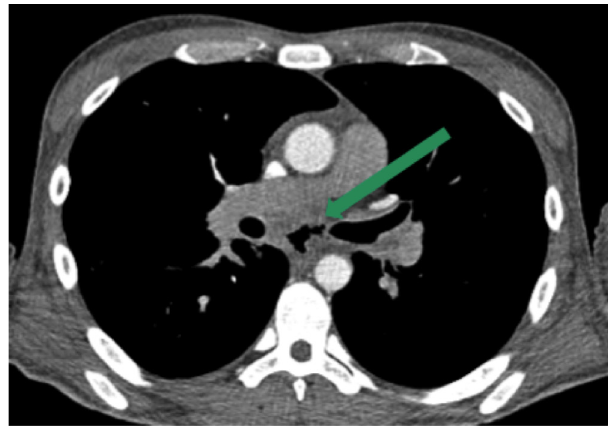
Figure 2. Chest CT on admission revealed esophageal discontinuity in the subcarinal region representing esophageal perforation (arrow).